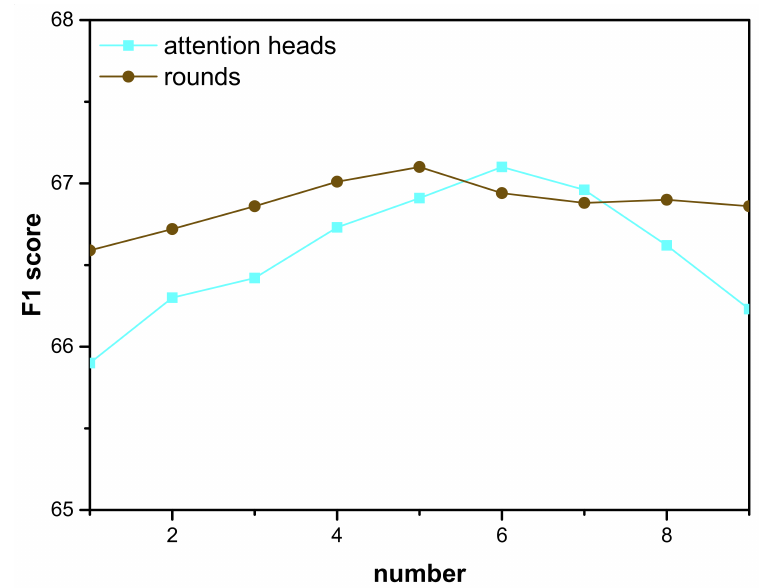
Figure 8. Experimental results on different numbers of attention heads h and different rounds r in extended